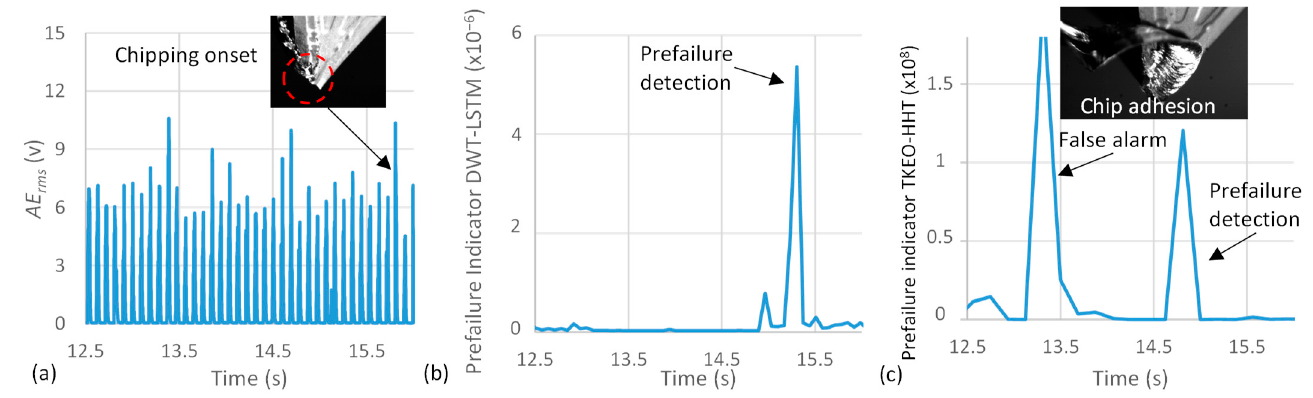
Figure 5. ( a ) Test 4 raw AErms signal, the corresponding ( b ) DWT-LSTM, and ( c ) TKEO-HHT prefailure indicators. prefailure